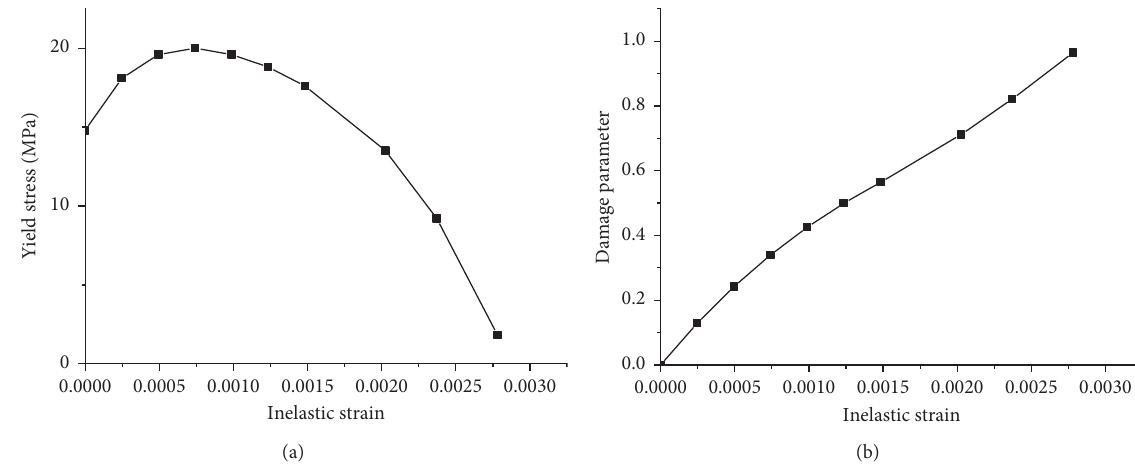
Figure 6: Dynamic compressive damage evolution curve of C